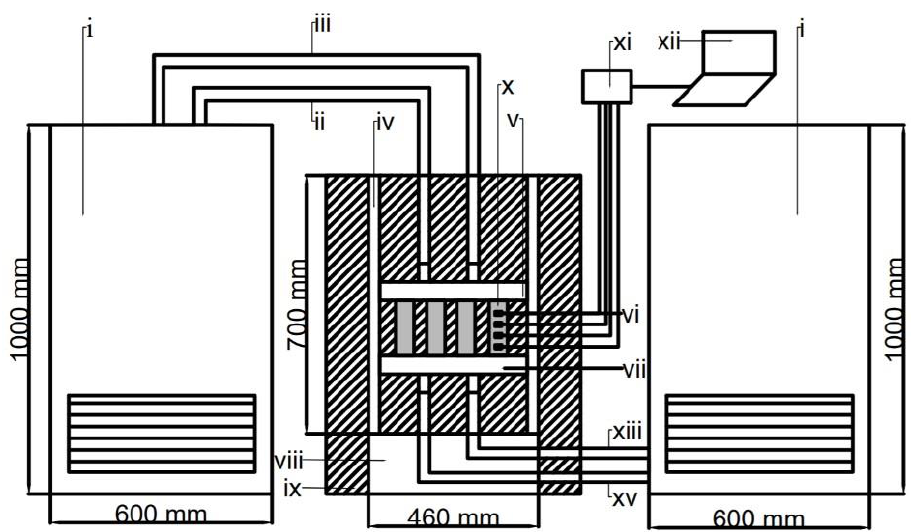
Figure 3. Unidirectional freezing test system. (i) Cold liquid circulator. (ii, xv) Liquid inlet. (iii, xiii) Liquid outlet. (iv) Thermostat. (v) Top plate. (vi) Temperature sensors. (vii) Bottom plate. (viii) Benchtop. (ix) Insulation material. (x) Silty clay samples. (xi) Data acquisition system. (xii) Com- puter.